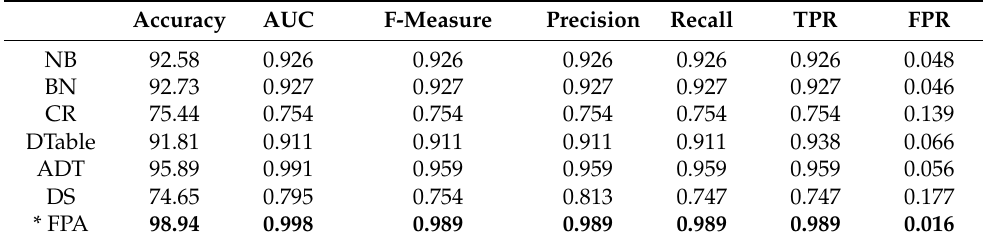
Table 6. Detection performances of FPA and baseline classifiers on the Malgenome dataset.